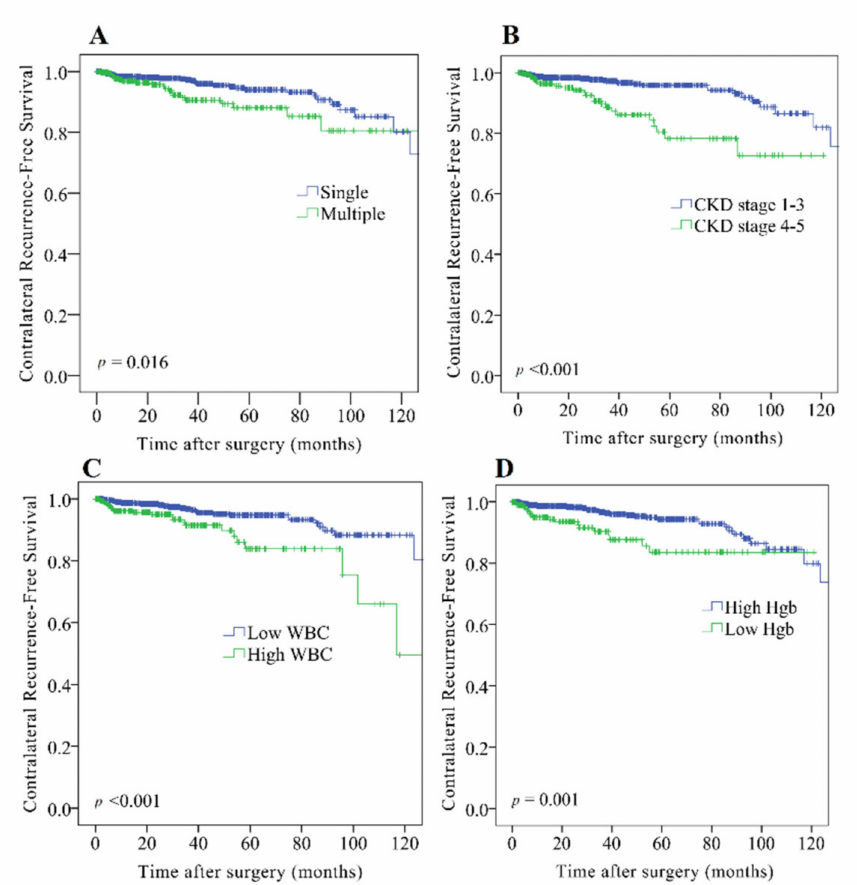
Figure 1. Kaplan–Meier analysis indicated that patients exhibiting ( A ) multiple tumors (log-rank p = 0.016), ( B ) advanced chronic kidney disease (CKD) (log-rank p < 0.001), ( C ) elevated white blood cell (WBC) count (log-rank p < 0.001), and ( D ) decreased hemoglobin level (log-rank p = 0.001) had significantly lower contralateral recurrence-free survival